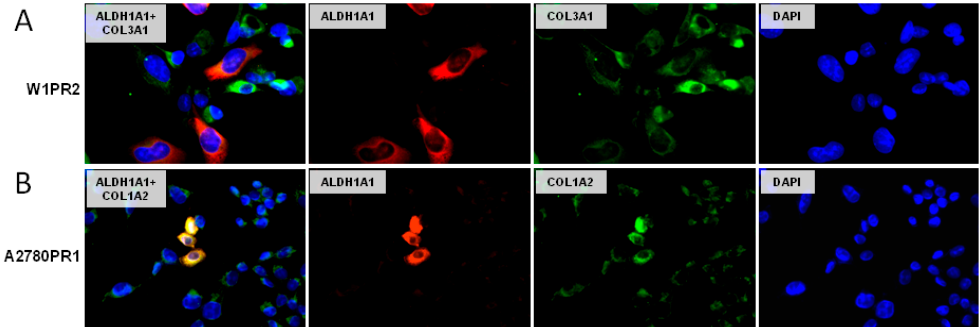
Figure 7. Immunofluorescence visualization of ALDH1A1 and COL3A1 coexpression in the W1PR2 cell line ( A ) and coexpression of ALDH1A1 and COL1A2 in the A2780PR1 cell line ( B ). ALDH1A1 was detected using the anti-ALDH1A1 antibody and Alexa Fluor ® 488-conjugated secondary antibody (green). COL3A1 and COL1A2 were detected using the anti-COL3A1 and anti-COL1A2 antibodies and Alexa Fluor ® 594-conjugated secondary antibody (red). To visualize the cell nuclei, the cells were mounted with a DAPI-containing mounting medium (blue). Objective 40×.